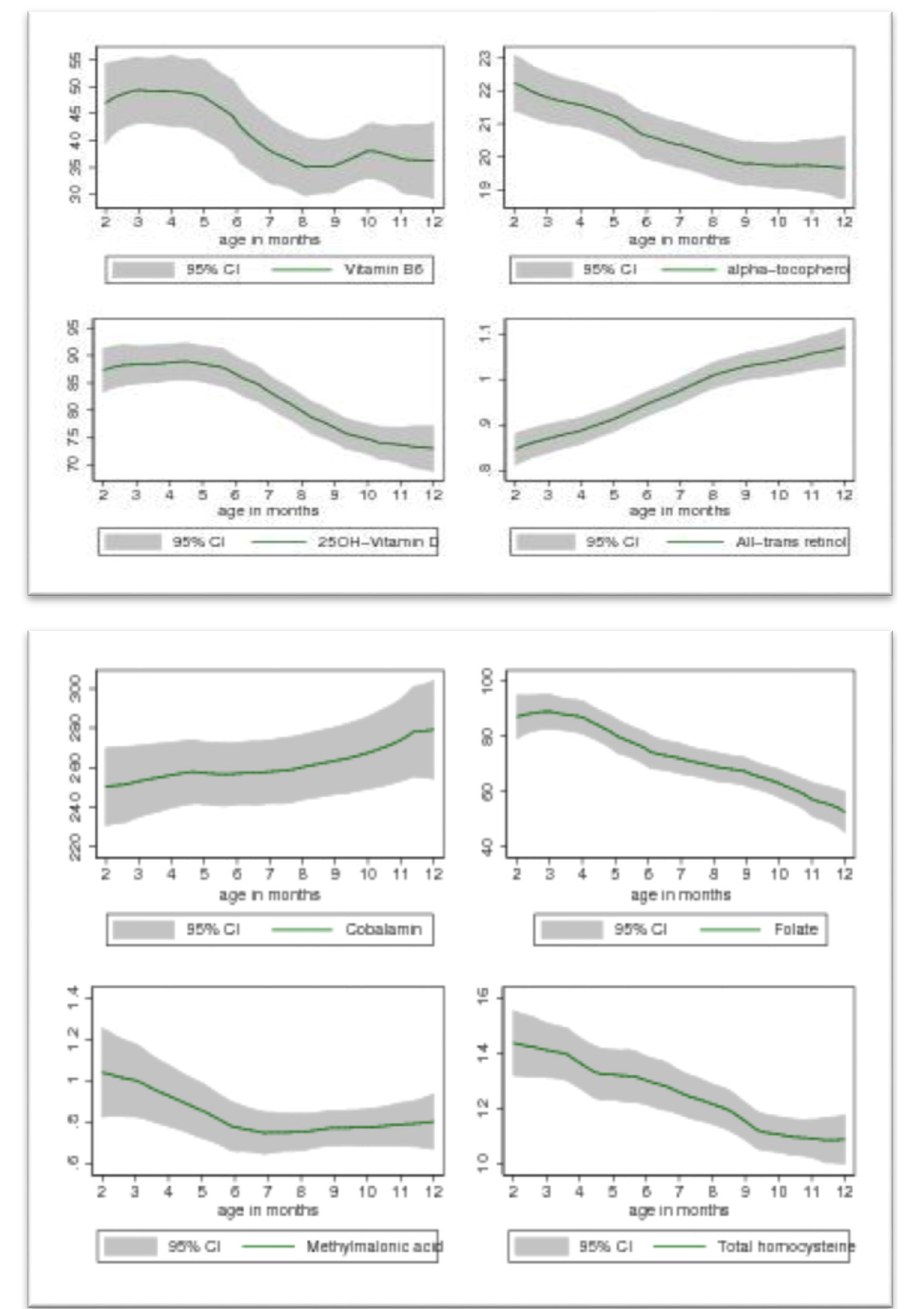
Figure 1. Association between vitamins of B 6 (pyridoxal 5 ′ phosphate nmol/L), E( α‐ tocopherol, µ mol/L), D(25(OH)D, nmol/L), A( trans retinol , µ mol/L) , B 12 (cobalamin, pmo/L), Folate(plasma folate, nmol/L), MMA( µ mol/L) and tHcy( µ mol/L) with age among 467 breastfed Nepalese infants. The Y axis indicate the mean concentration of plasma vitamins or metabolic markers. X axis indicate the age of the child. The shaded area represents 95% CI of the plasma vitamins and metabolic markers.